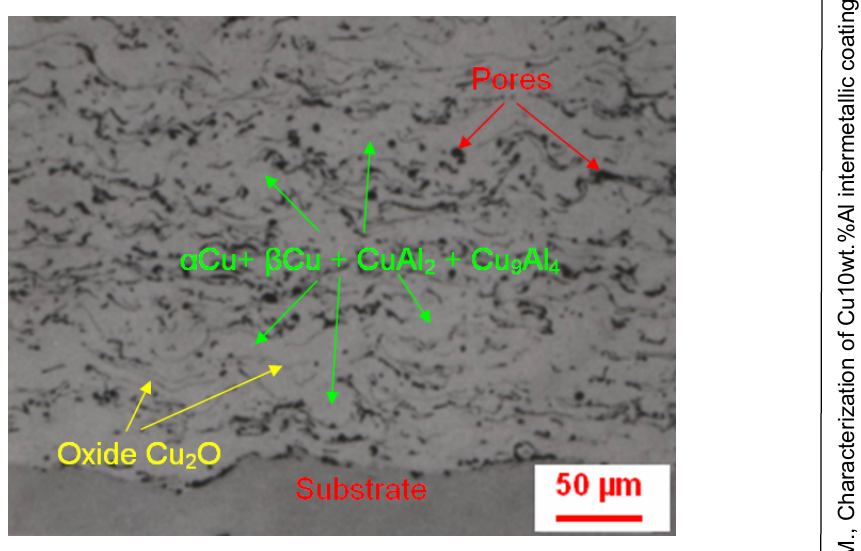
Figure 3 – (OM) Cu10wt.%Al coating microstructure Рис . 3 – ( ОМ ) Микроструктура Cu10 вес .%Al